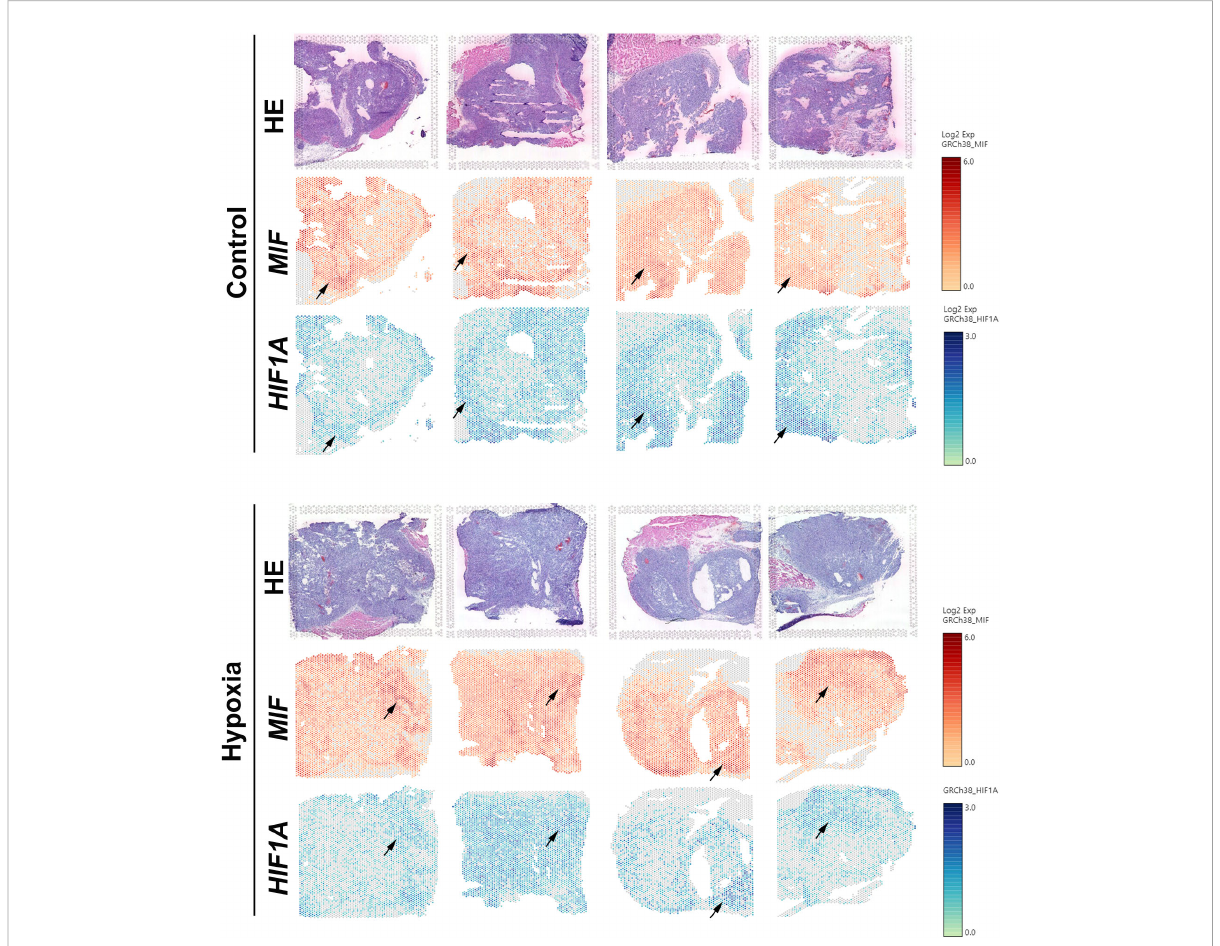
FIGURE 2 Visualization of the expression patterns of HIF1A and MIF genes in PDAC xenografts by spatial transcriptomics Spatially resolved expression of HIF1A and MIF in tumour sections taken from 8 PDAC xenografts subcutaneously in the mouse groin after femoral artery ligation of the left hind limb (hypoxia) or sham operation